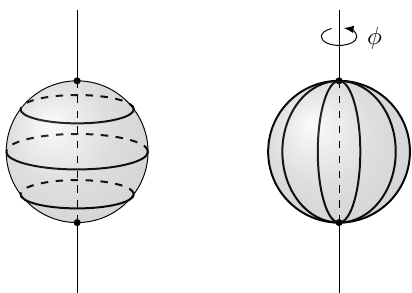
Figure 3 . Susskind and Uglum considered the generalized entropy of perturbative closed strings in flat space, viewed as a limit of the cigar geometry. Using off shell arguments, they computed generalized entropy by inserting a conical singularity in the background, corresponding to the tip of the cigar geometry. In perturbative string theory, the area term comes from the sphere diagram which intersects the conical singularity. Viewed in the open string channel, this is a one-loop open string diagram. This interpretation amounts to an open-closed string duality which identifies Bekensten Hawking entropy as thermal entropy of open strings that end on the conical singularity. Figure borrowed from ref.